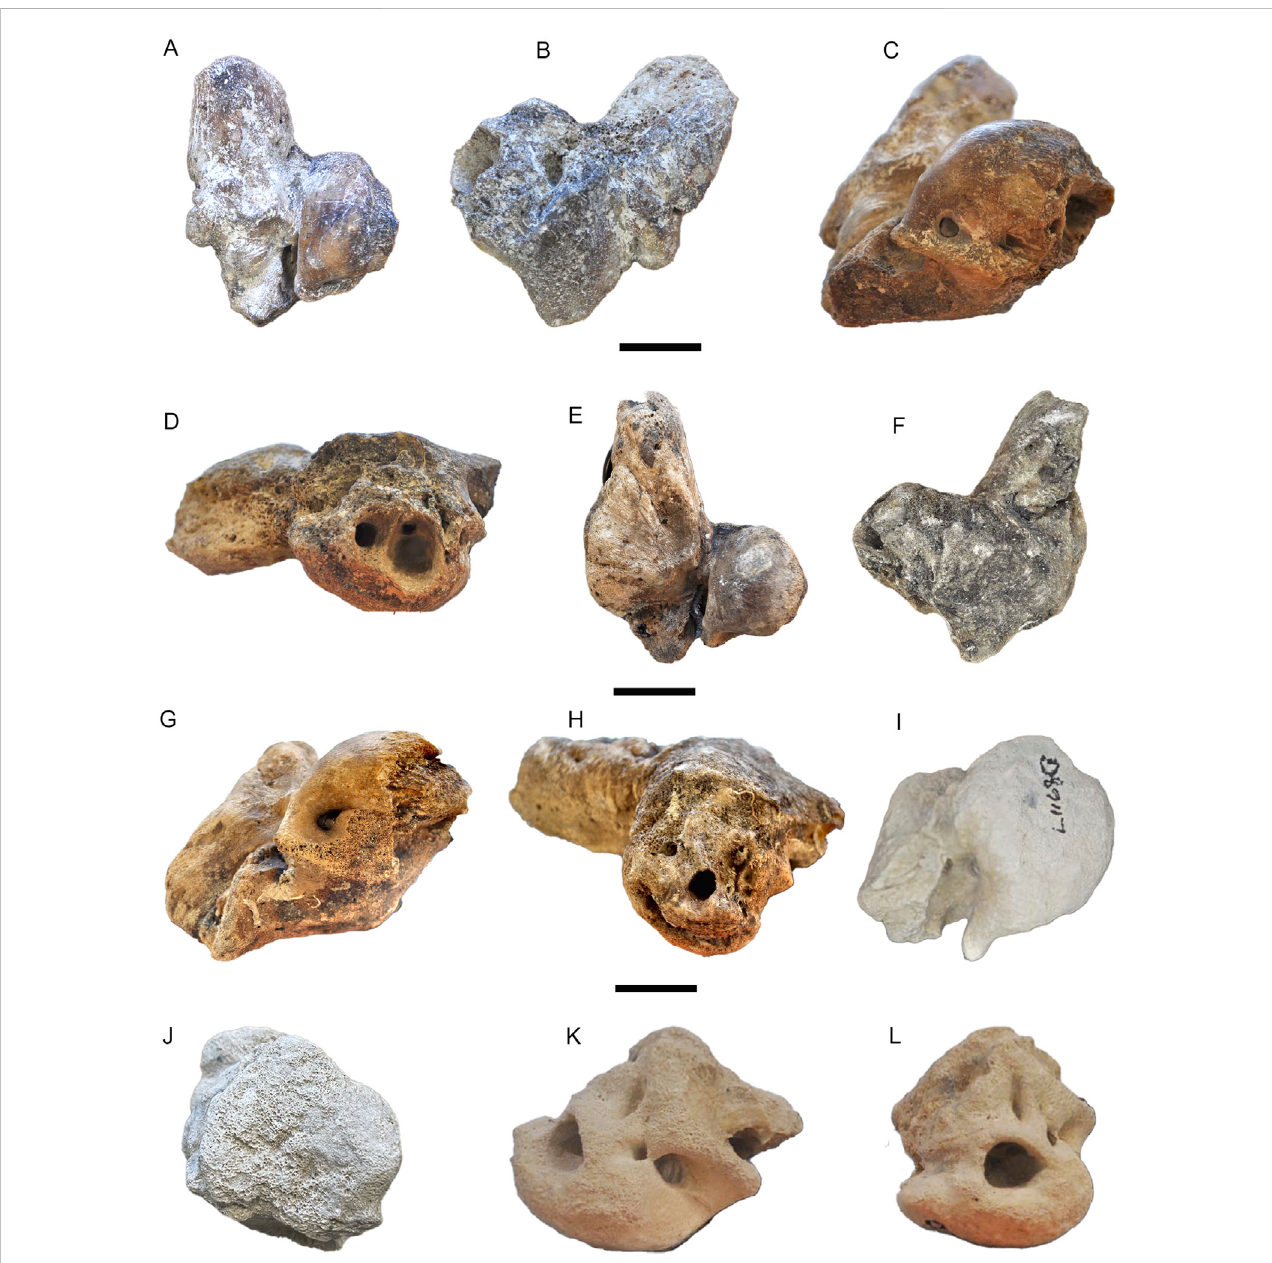
FIGURE 5 Balaenopteridae indet. A SAM-PQ-3095 in (A) ventromedial, (B) lateral, (C) posterior, and (D) dorsal view, scale=2 cm. Balaenopteridae indet. SAM-PQ- 3081 in (E) medial, (F) lateral, (G) posterior, and (H) dorsal view, scale=2 cm. SAM-PQL-11680, (I) ventromedial, (J) lateral, (K) posterior, and (L) dorsal view, scale=2